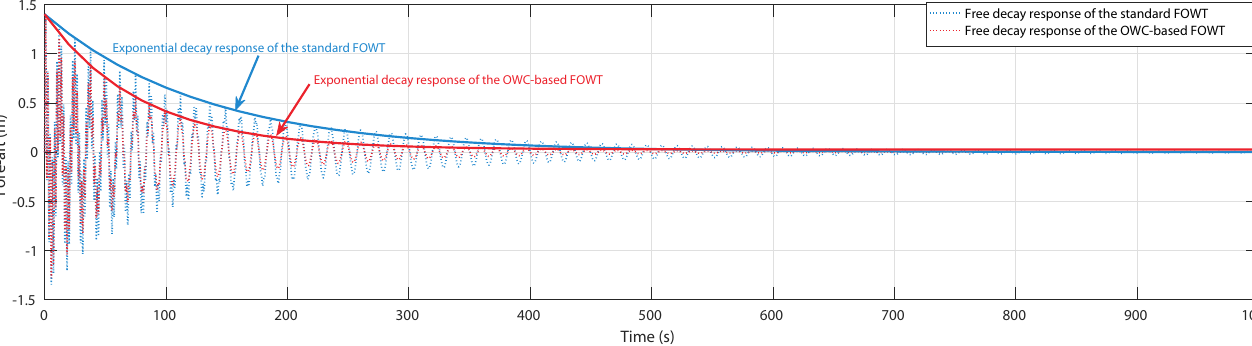
Figure 5. Free decay response for the tower top fore-aft displacement in the standard FOWT and OWC-based FOWT. Using the exponential decay method, the damping ratios for the platform pitch is of 1.84% in the case of the OWC-based FOWT structure whereas it is of 1.66% in the case of the standard FOWT structure. On the other hand, the damping ratio for the tower fore-aft is of 1.27% in the case of the OWC-based FOWT structure, whereas it is of 0.86% in